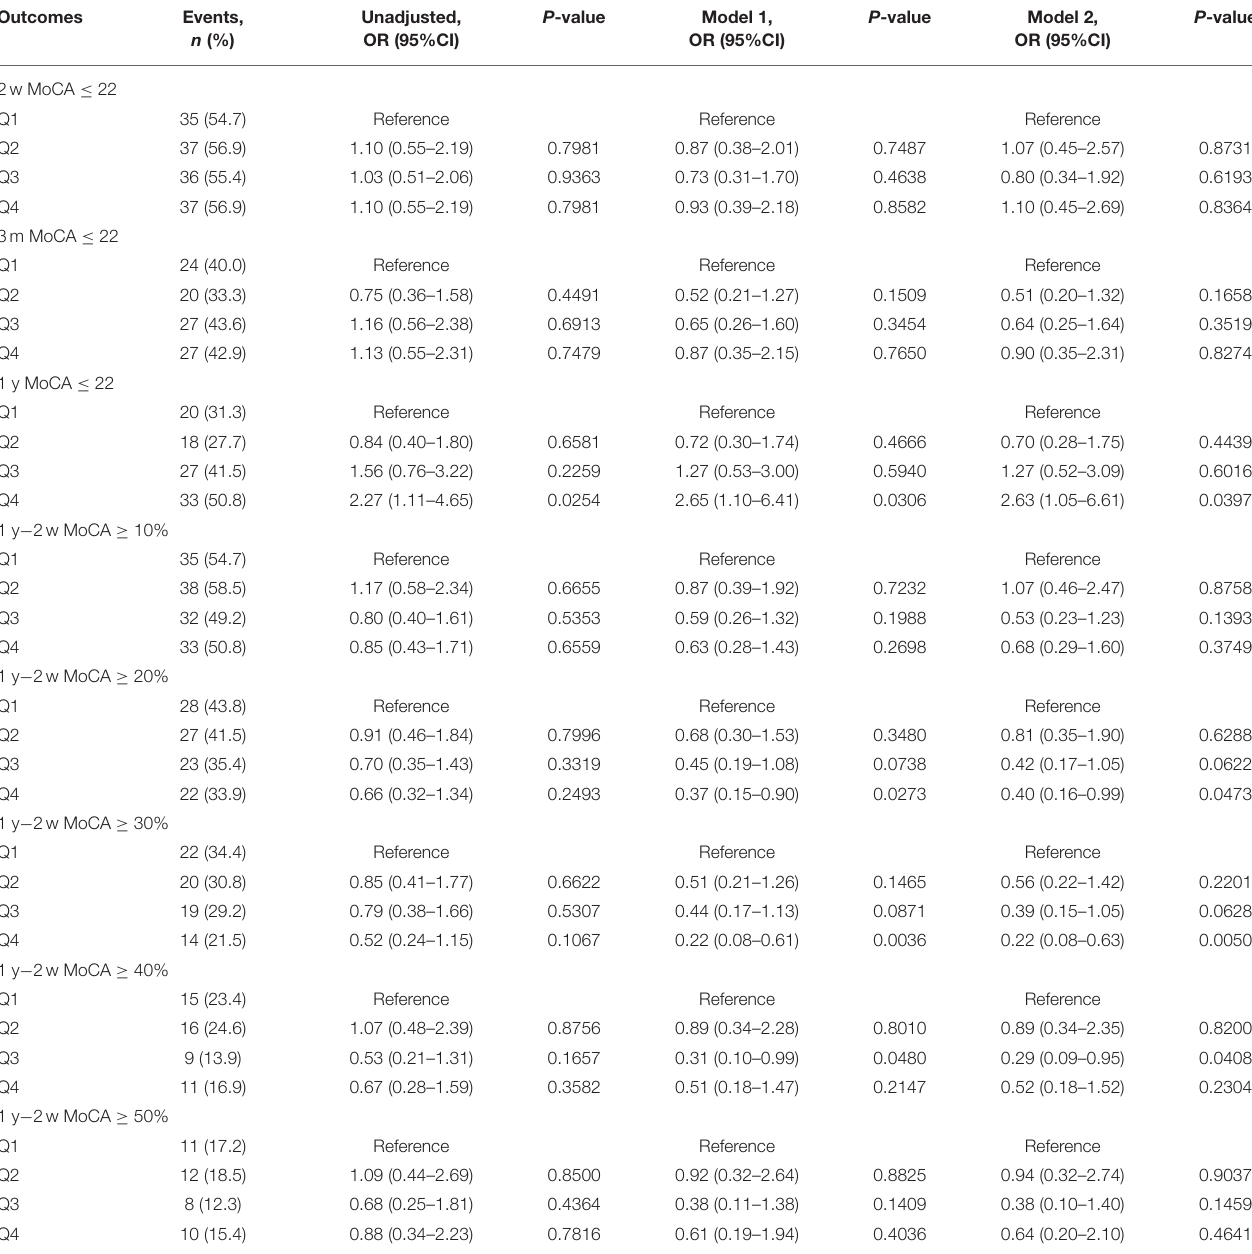
TABLE 3 | Subgroup analysis in patients with large-artery atherosclerosis (LAA) subtype.